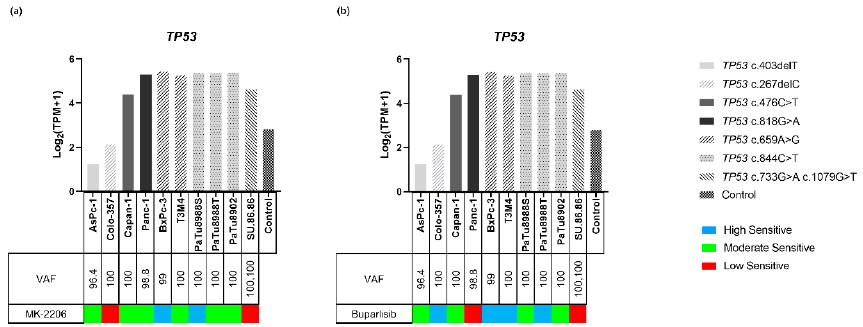
Figure 6. Gene expression of TP53 in ten PDAC cell lines and the control. The sensitivity to MK-2206 ( a ), Buparlisib ( b ), and the variants of TP53 are indicated for each cell line. Gene expressions are displayed as Log 2 (TPM + 1). Missense variants were related to overexpression, while frameshift variants were related to the inhibition of gene expression.